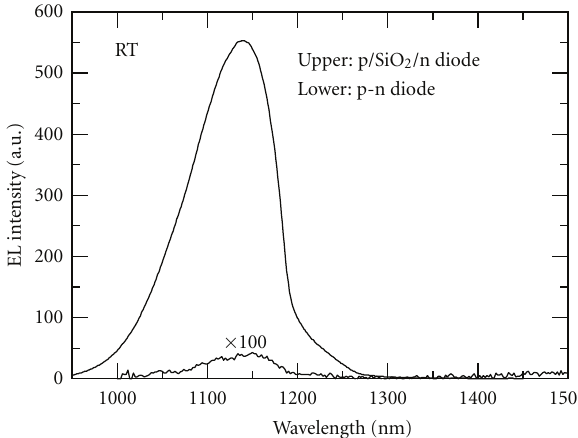
Figure 2: Room temperature electroluminescence spectra of a p- Si/SiO 2 /n-Si diode (upper) and a p-Si/n-Si diode